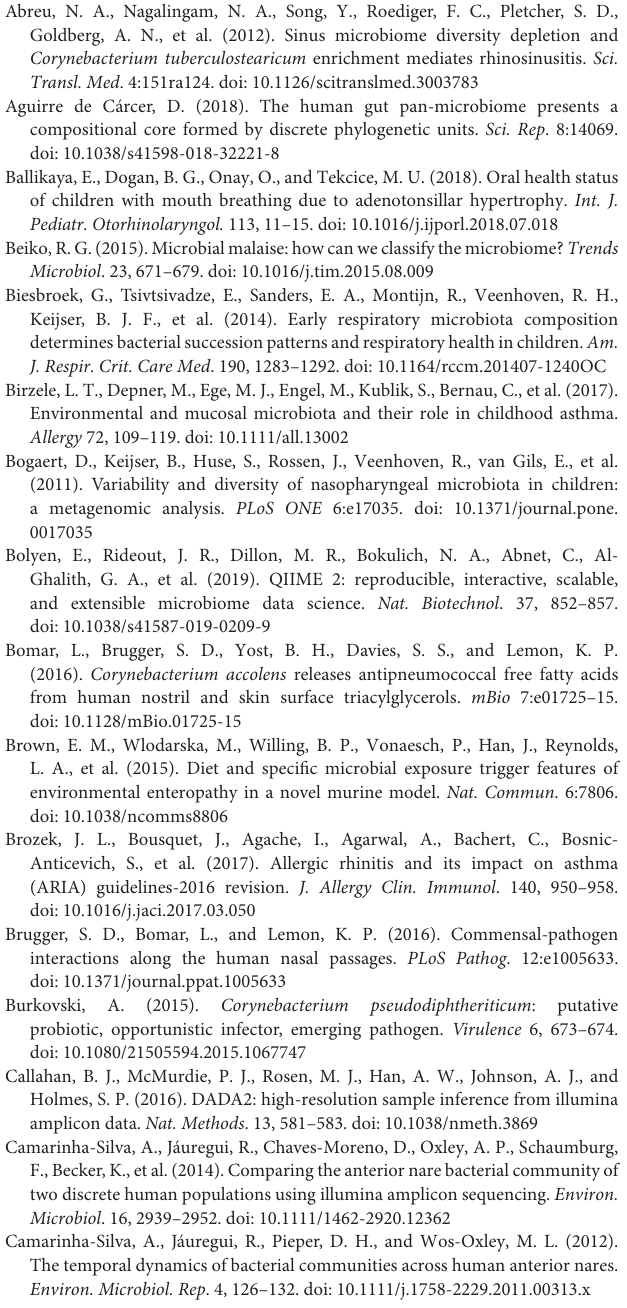
Table S1 | Detailed information about the ROC curves computed for CAT and DAT between control and diseased subjects. The Area Under Curve (AUC), its